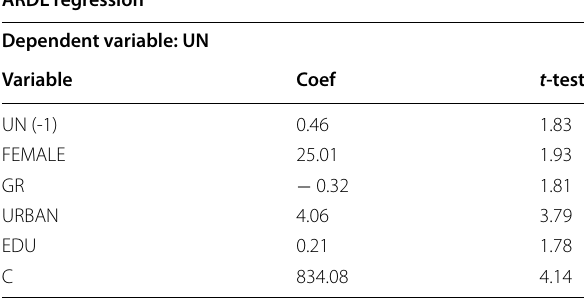
Table 4 ARDL regression